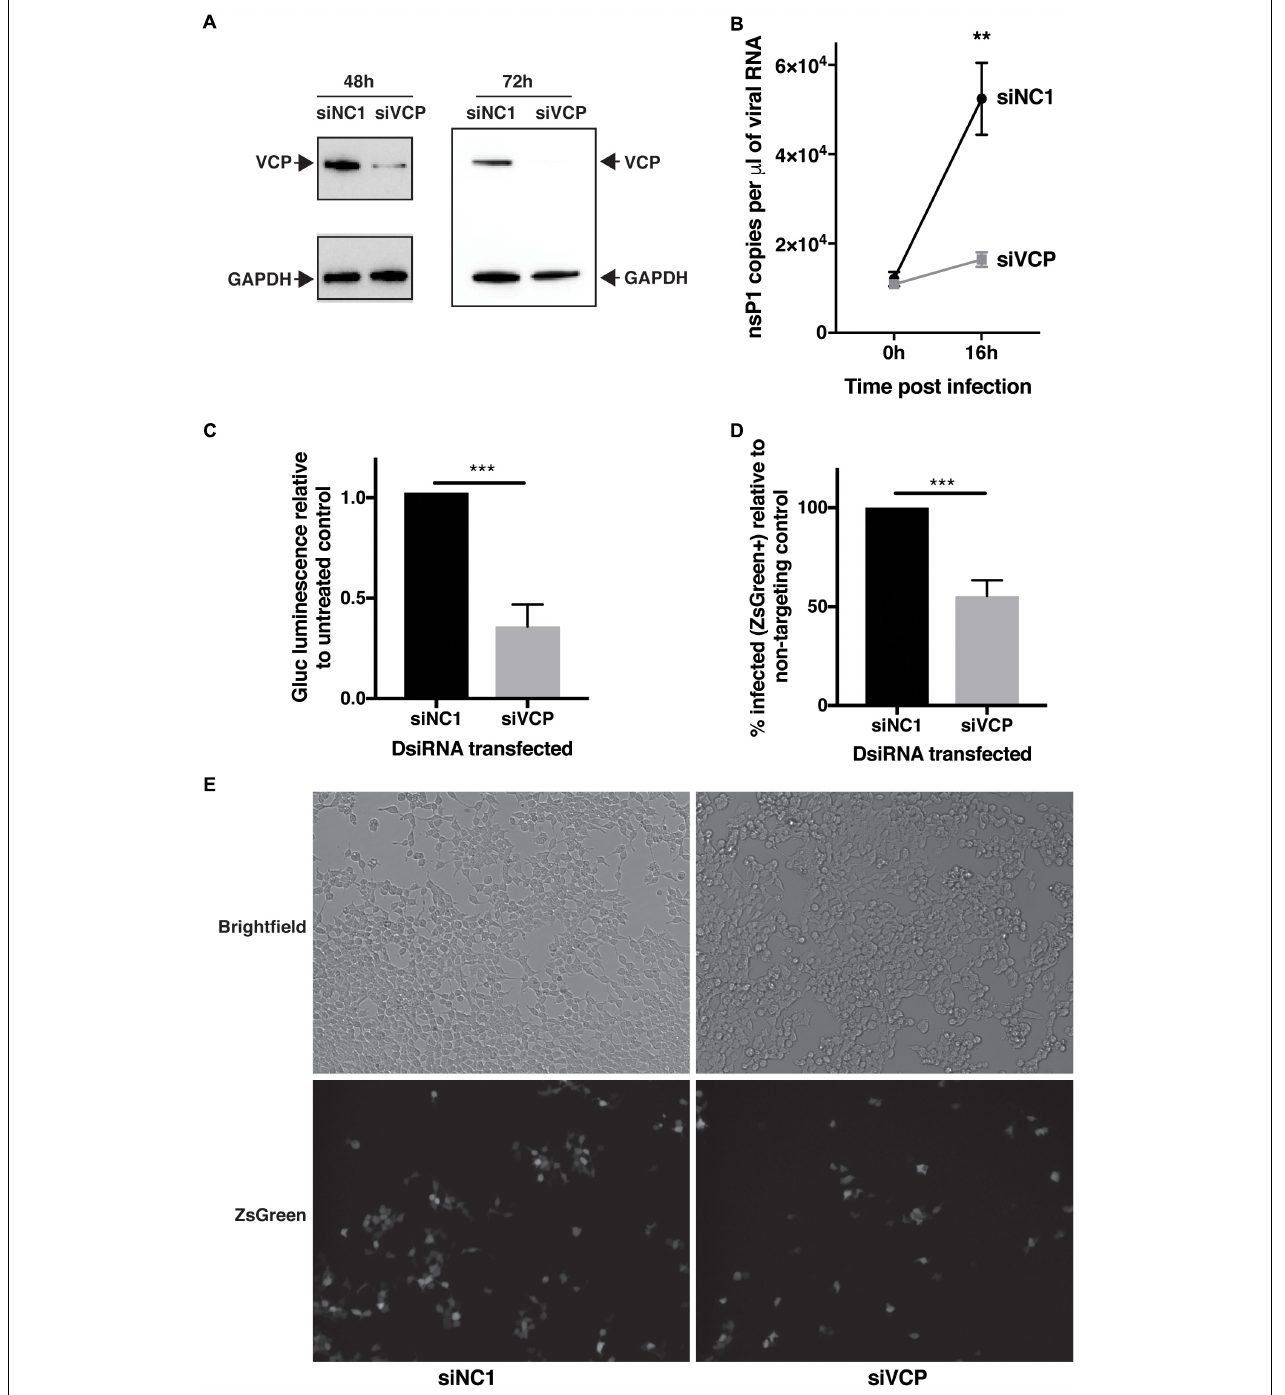
FIGURE 1 | VCP knock-down affects CHIKV infection. HEK 293T cells were transfected with 10 nM of siRNA. siNC1 is a non-targeting control and siVCP is a mix of three individual siRNA targeting VCP. At 48 h post transfection, cells were infected with Gluc- or ZsGreen-tagged virus per well, inoculum was not removed, to obtain 0 hpi time point, 140 µ L of supernatant was collected immediately after addition of inoculum. At 16 h post-infection, supernatant was collected or cells were imaged and harvested for flow cytometry analysis, respectively. (A) Representative western blot images of three independent experiment for VCP and GAPDH expression on cell lysates at 48 and 64 h post transfection. (B) Taqman quantification of viral RNA in the cell supernatant at 0 and 16 hpi. (C) Gaussia luciferase luminescence relative to siNC1. (D) % of FITC positive (infected) cells in siVCP-transfected cells relative to siNC1-transfected cells analyzed by flow cytometry. (E) Representative images of brightfield (auto exposure) and FITC (fixed exposure) channel on an epi-fluorescence microscope at 16 hpi. The data are presented as mean ± SD from minimum three independent experiments (two for panel B ) and were analyzed by Mann–Whitney non-parametric two-tailed test; ∗∗ p < 0.01; ∗∗∗ p < 0.001.